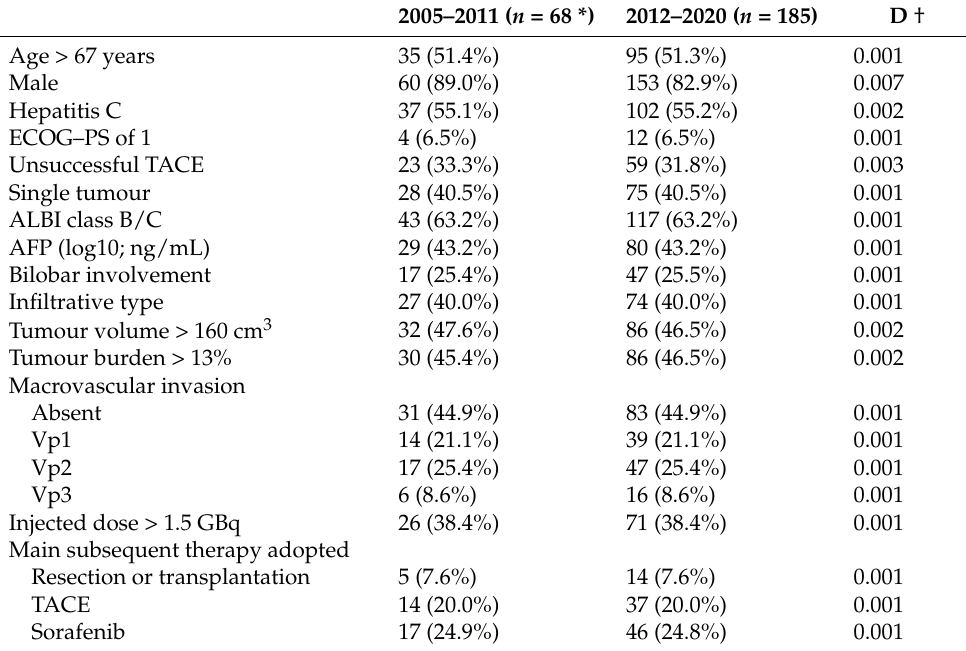
Table 2. The distribution of clinical and radiological characteristics after entropy balance